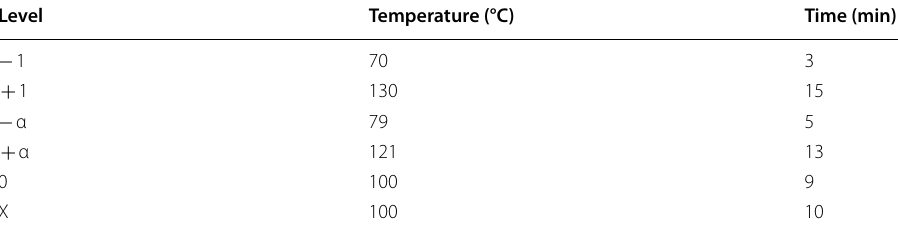
Table 2 Experimental rotatable central composite design (RCCD) matrix levels selected for temperature and